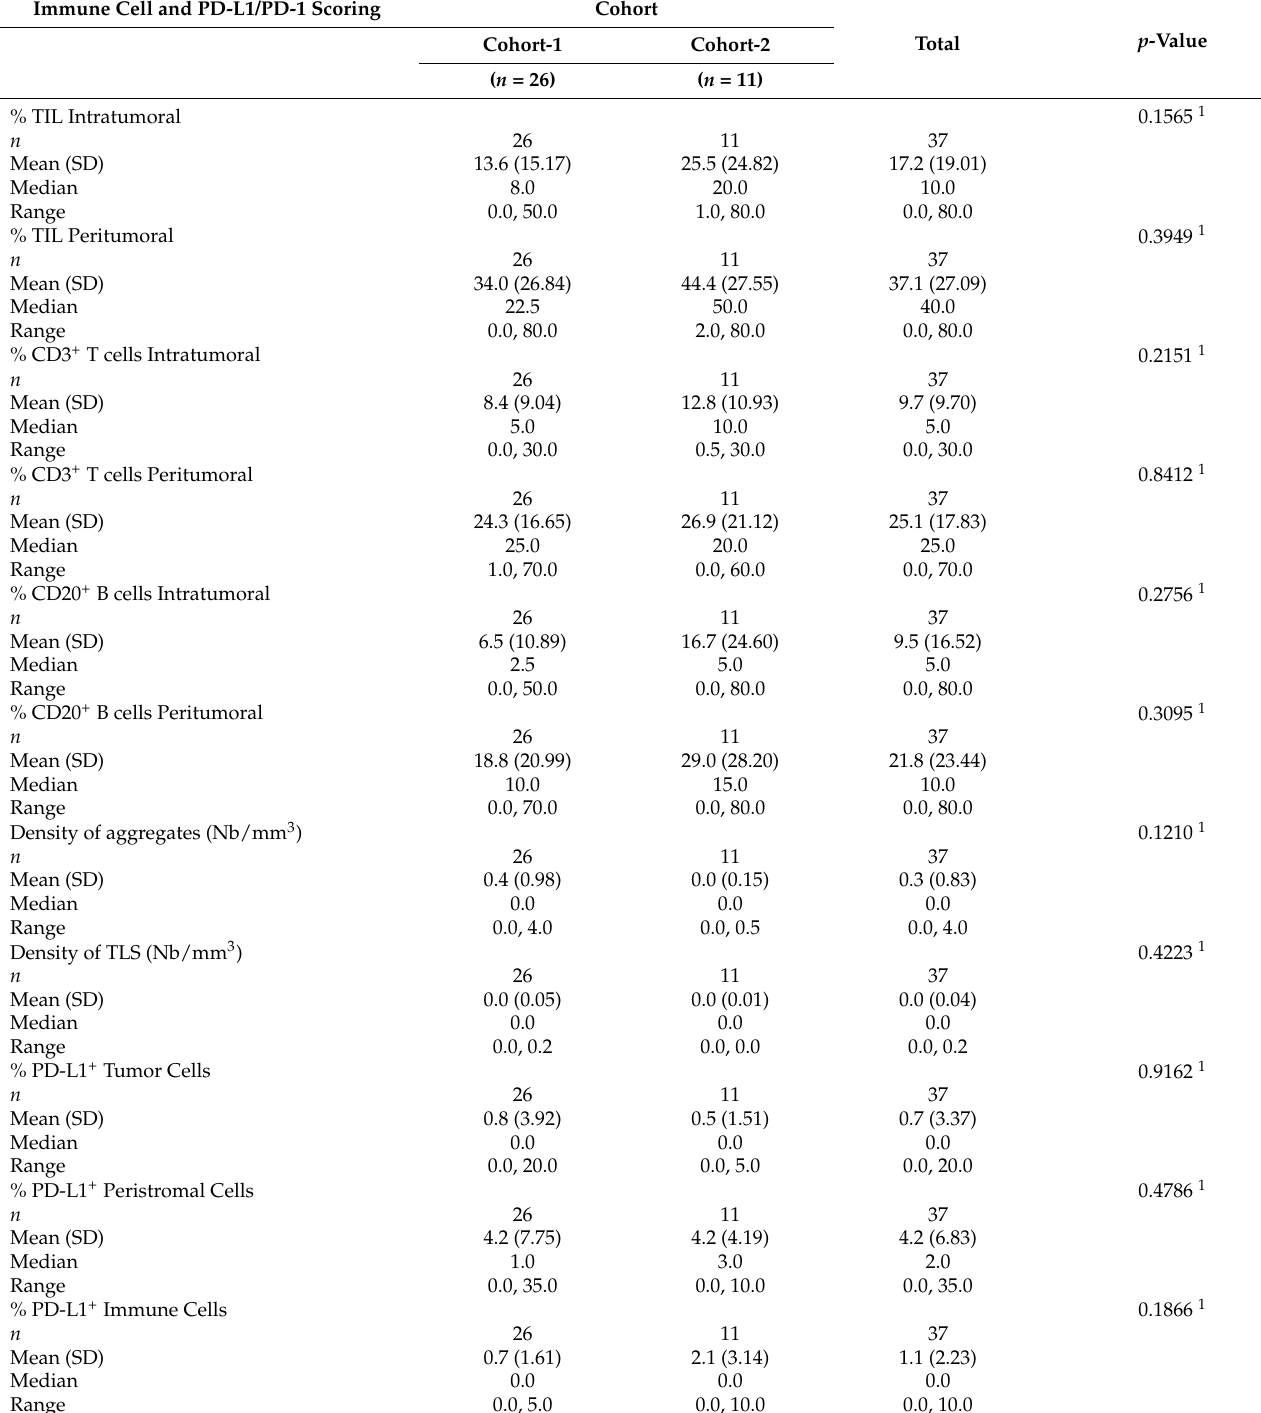
Table A1. Immune characteristics of melanoma